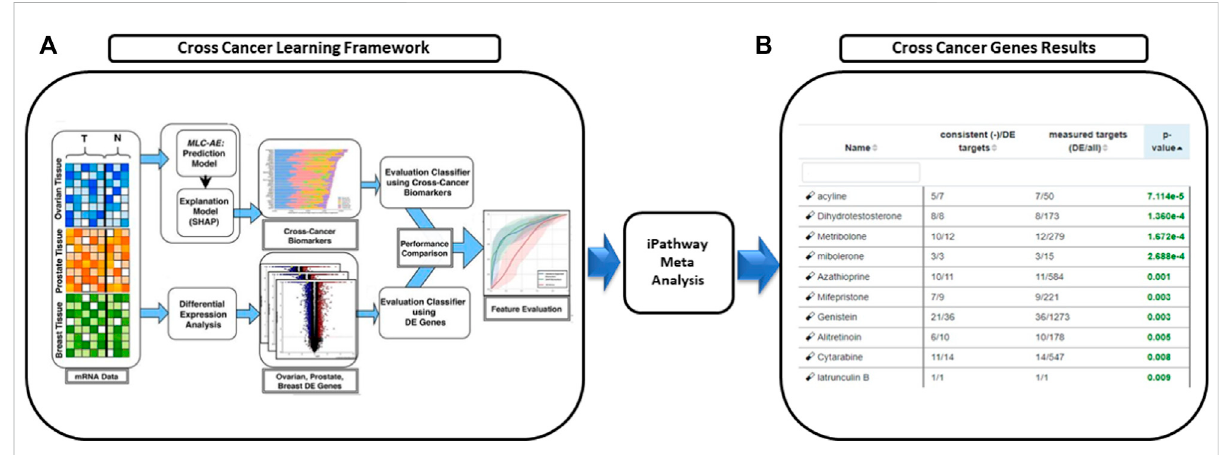
FIGURE 6 Drugs proposed using cross cancer genes. (A) Breast, prostate and ovarian cancer expression data was used to predict the tissue type and the disease type using multi-label classi fi cation — auto encoder (MLC-AE). SHAP Explanation model was used to identify the contribution of each gene towards the prediction using SHAP values that rank the genes. (B) Network interaction analysis was used to perform meta analysis and predict novel drugs.